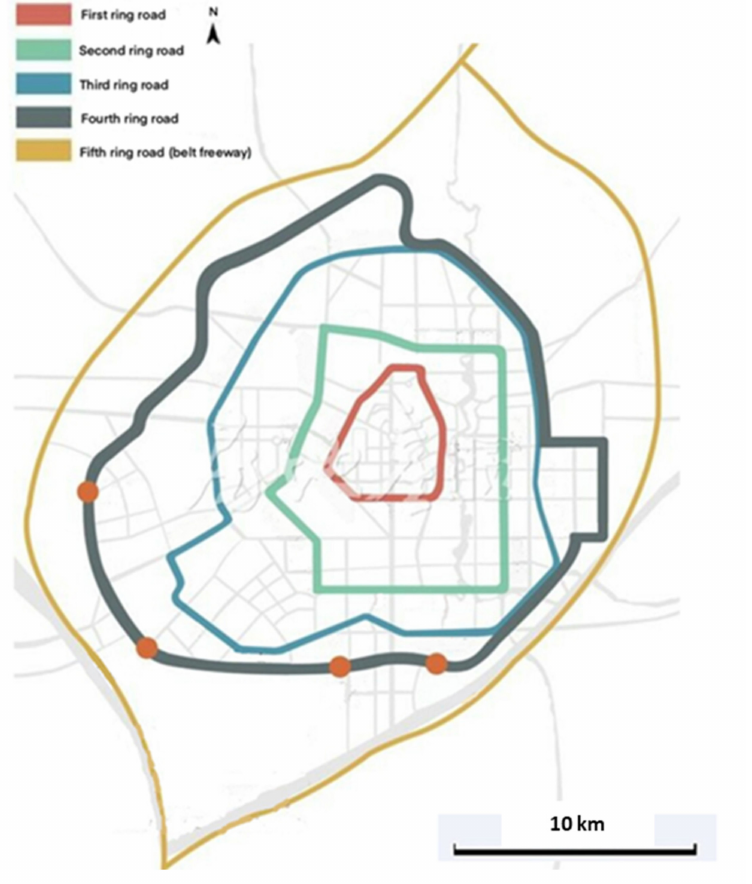
Figure 3. Ring road map of Changchun